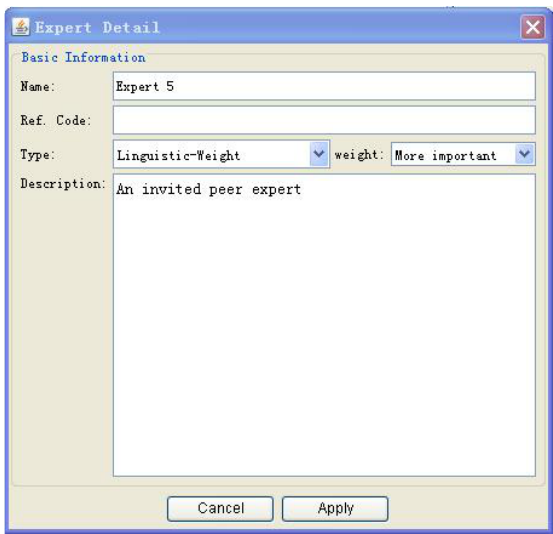
Fig.9. An evaluator’s information and